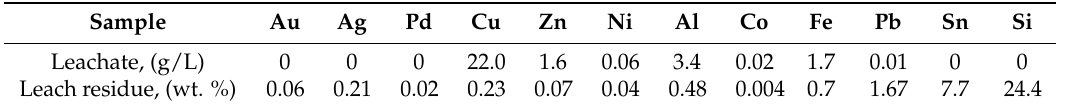
Table 2. The chemical composition of the leachate and the solid residue of the WPCBs ash after high-pressure oxidative leaching (HPOL).